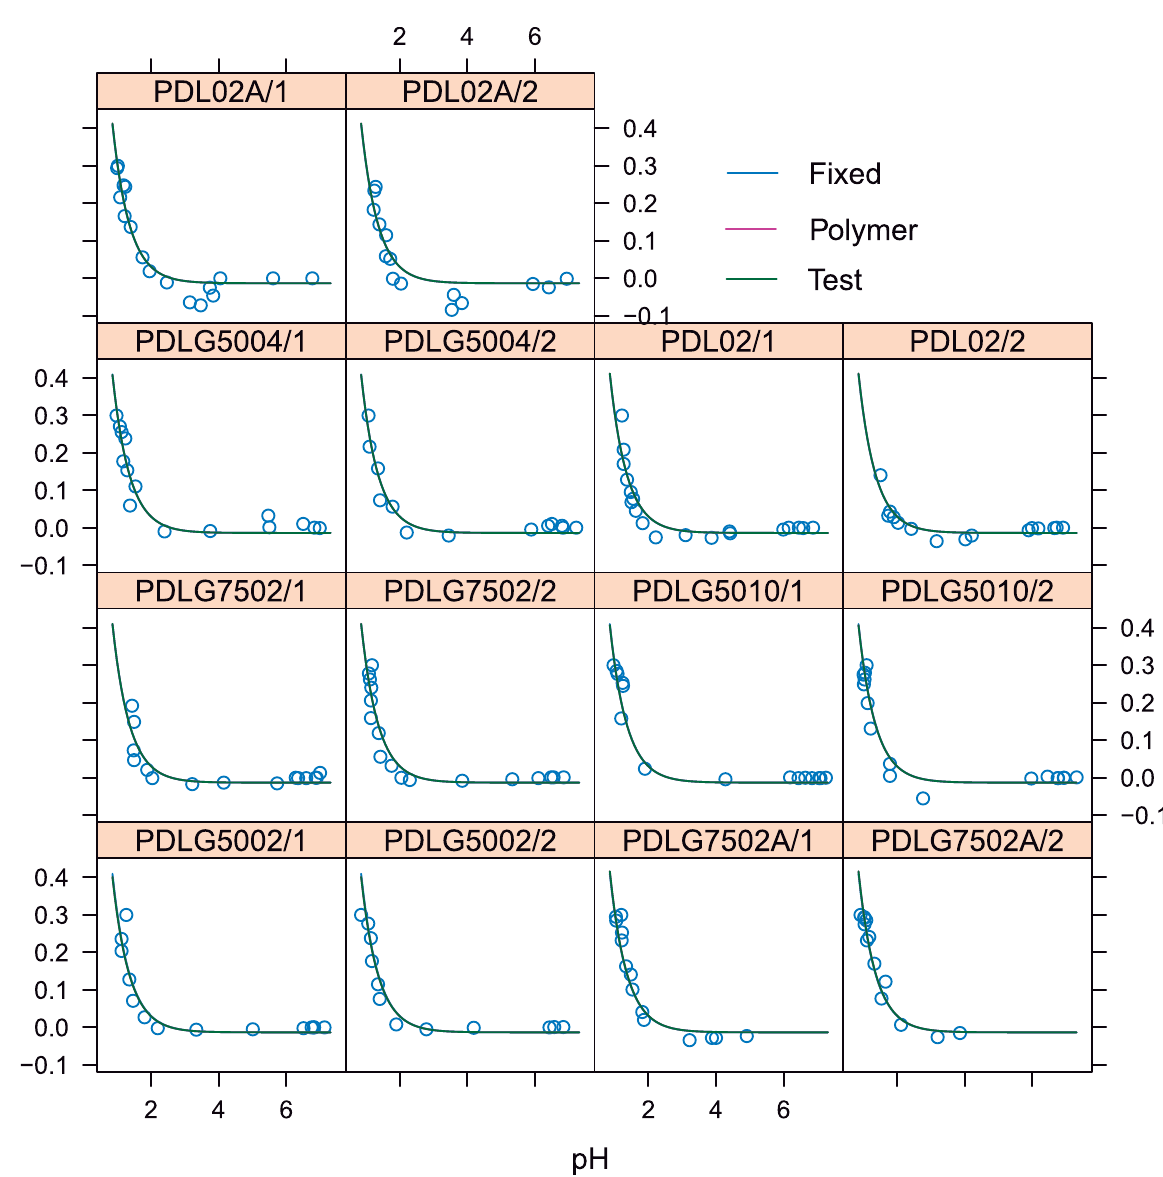
Fig 11. Each panel shows the PDLGA mass loss versus pH for each test/replicate nested in PDLGA polymer factor. The nonlinear mixed-effects fitting for each test is shown and compared with respect to fittings corresponding to each polymer, and the fitting corresponding to the population (and obtained using the fixed effects of model